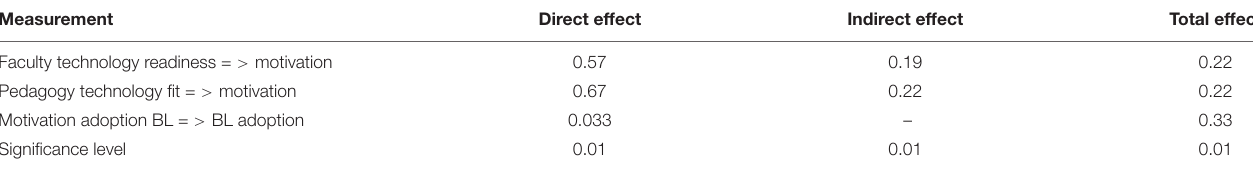
TABLE 10 | Direct, indirect and total effects of re-specified